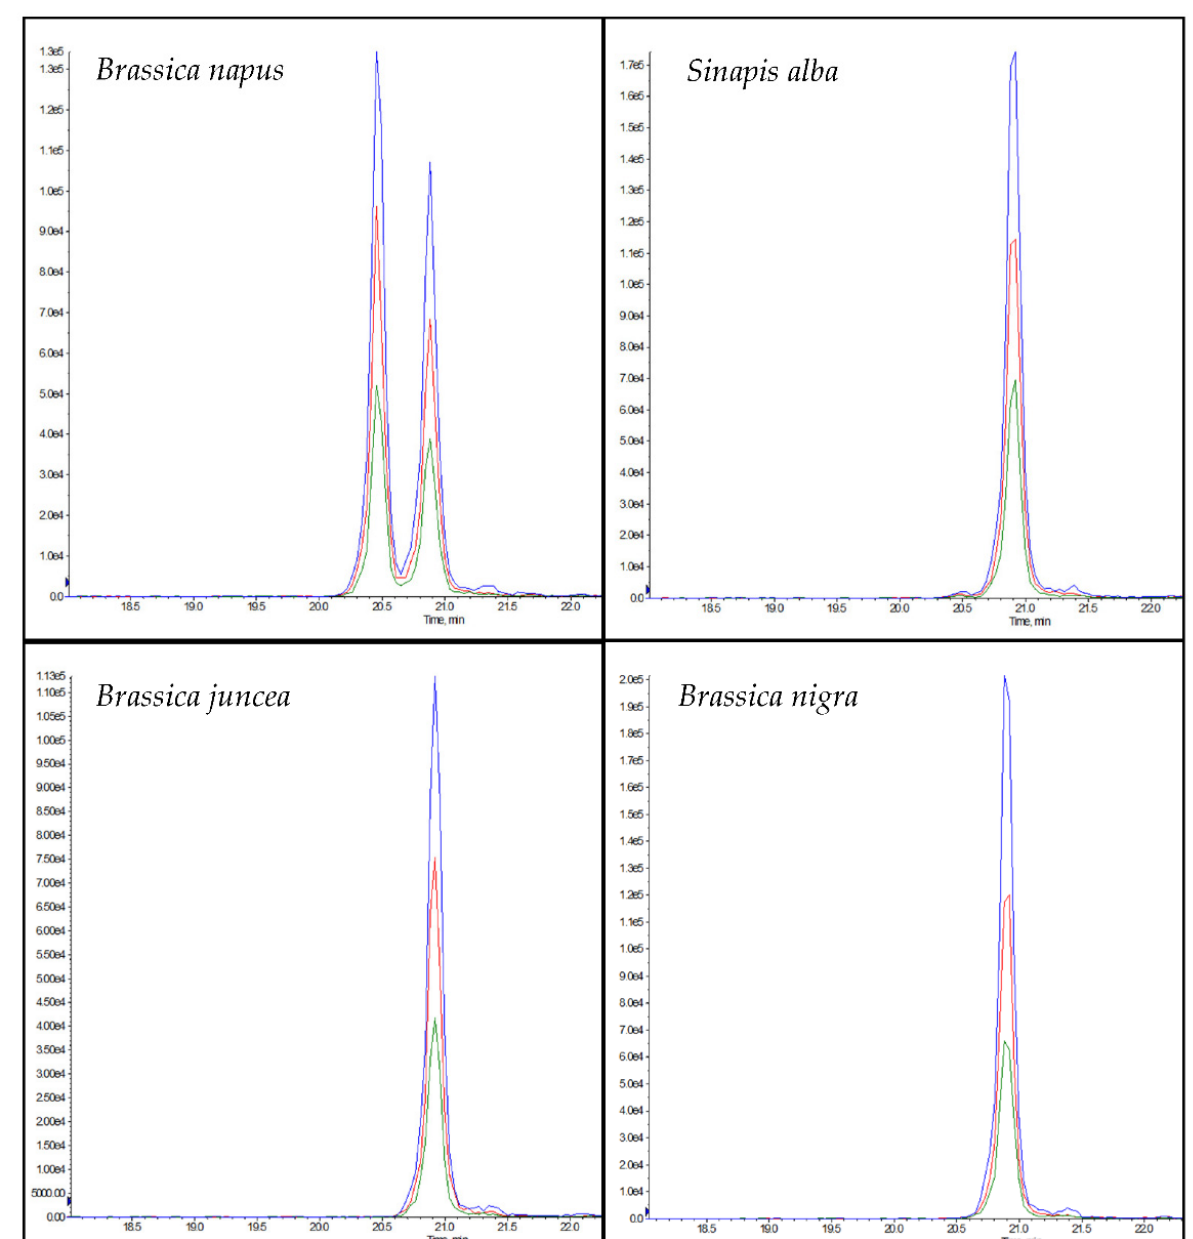
Figure 4. Chromatograms of the peptides NLRPFLIAGNNPQGQQWLQGR (rapeseed 1, RT: 22.5 min) and NLRPFLLAGNNPQGQQWLQGR (isomer to rapeseed 1, t R : 22.9 min) in the different pure plant flours of rapeseed ( Brassica napus ), white mustard ( Sinapis alba ), brown mustard ( Brassica juncea ), and black mustard ( Brassica nigra ).